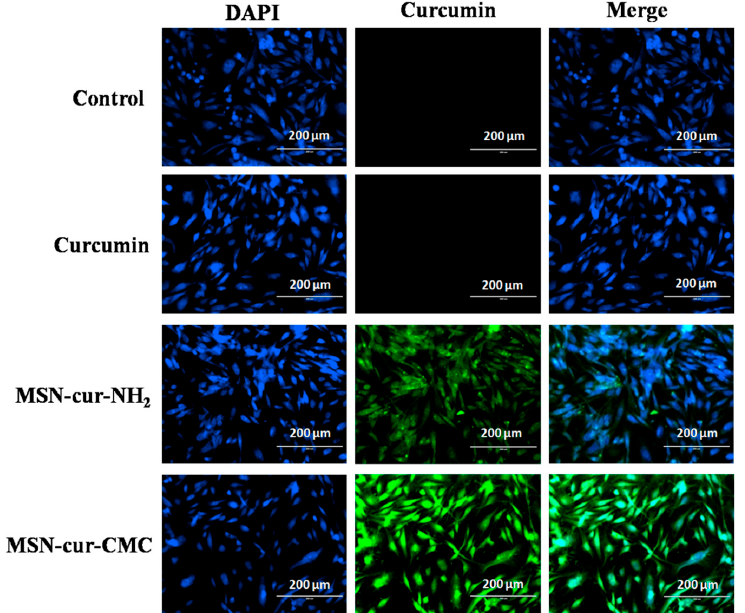
Figure 7. Intracellular uptake of –NH 2 and –CMC functionalized MSNs using fluorescence microscopy. Images of MDA-MB-231 incubated with 16 µg/mL of free curcumin, MSN-cur-NH 2 (GI 50 = 7 µg/mL) and MSN-cur-CMC (GI 50 = 1.5 µg/mL). Control refers to the non-treated